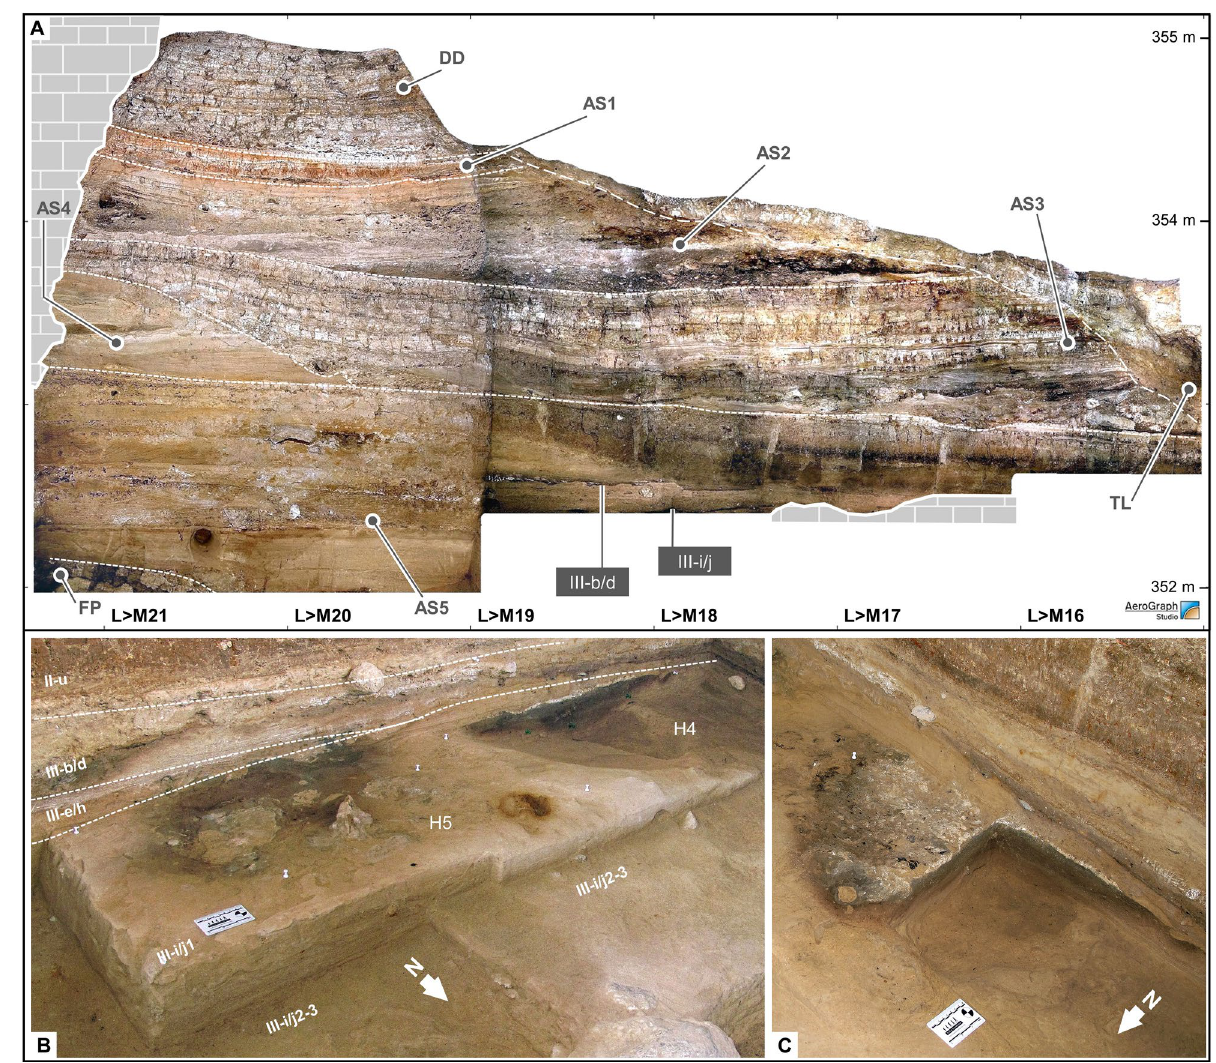
Figure 2. Stratigraphy and hearths. ( A ) The reference profile, with indication of the main stratigraphic subdivisions (elevations in m asl). ( B ) Oblique view of the baulk containing the H4 and H5 hearths during the excavation of layer III-i/j (2012 field season). ( C ) Detail of H4 during the initial phase of its excavation, showing the internal micro-stratigraphy typical of in situ fire features: a white ash lens denoting the occupation surface and overlying a basin-shaped, red-rimmed volume of black sediment denoting the burning of subsurface organic